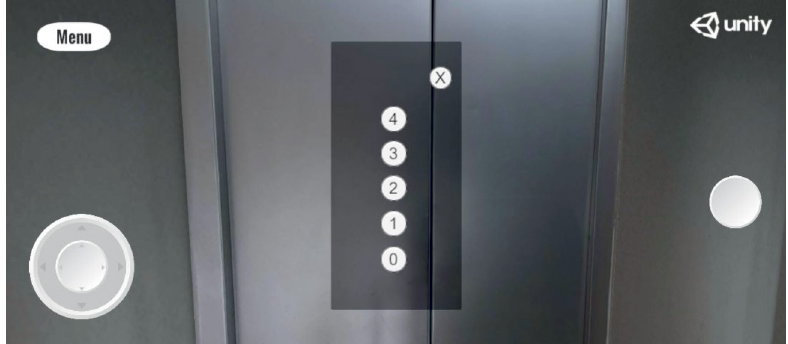
Fig. 10. Floor selection panel in the elevator